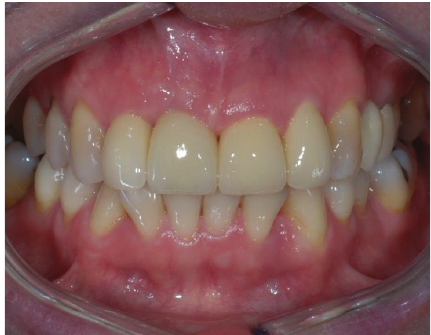
Figure 26: Frontal view after prostheses